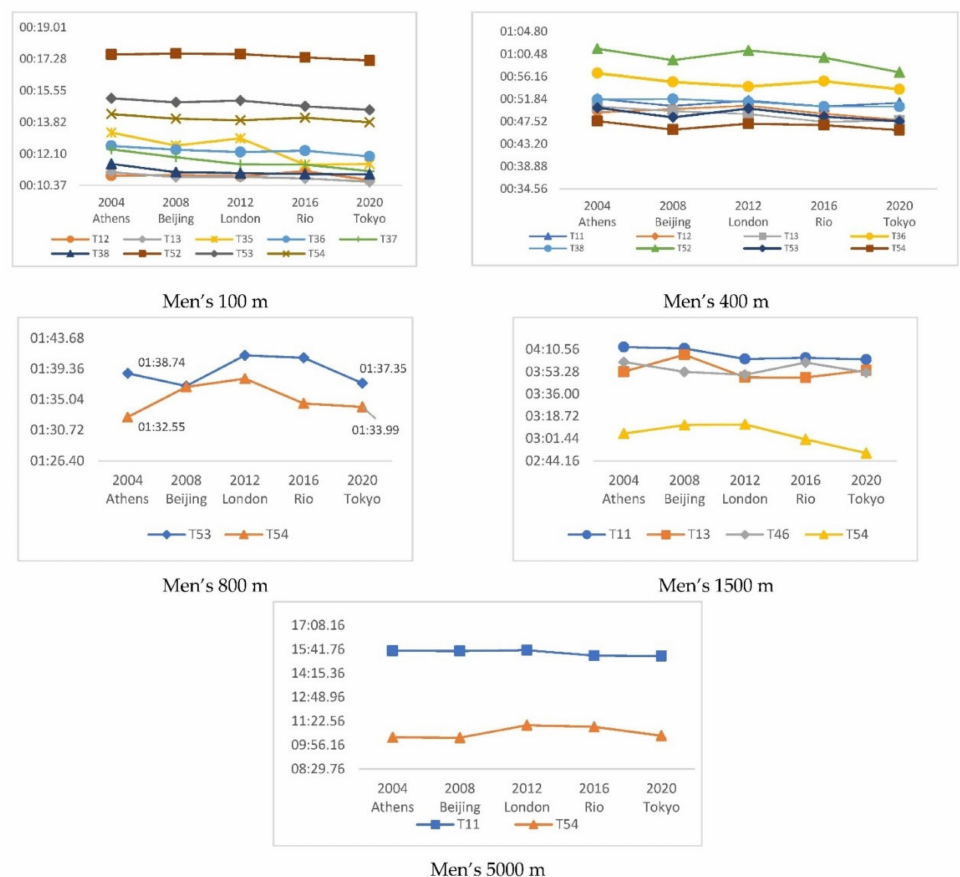
Figure 1. Men’s Division Records Change Trends in the Track Events of the Paralympic